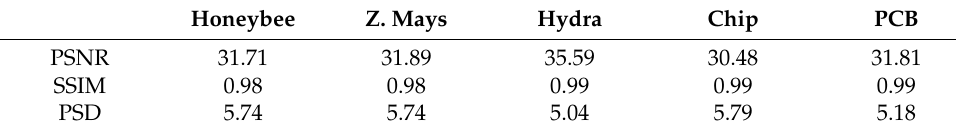
Table 3. × 8 upscaling directional view image comparison using the proposed algorithm.